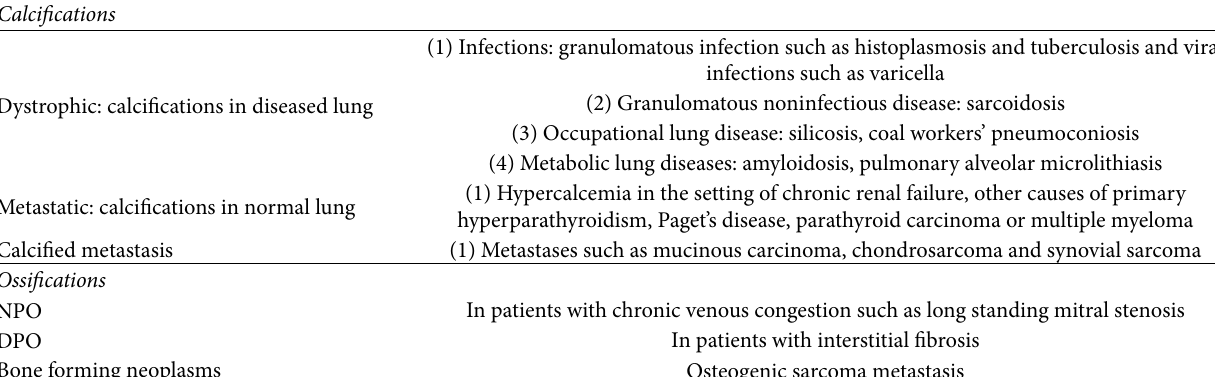
Table 2: Differential diagnosis of pulmonary calcifications and ossifications.